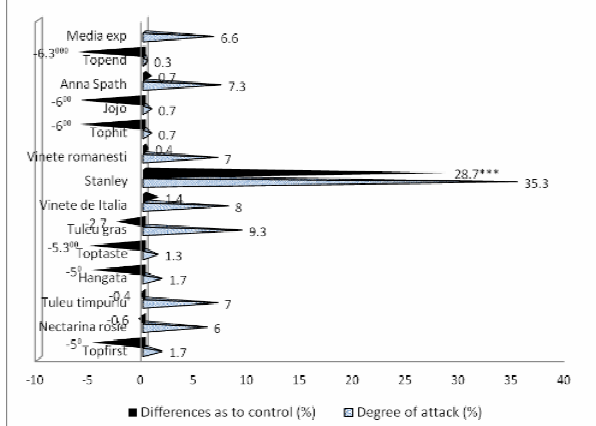
Fig. 3. The response of plum cultivar to leaf blister ( Monilinia laxa ) attack on flowers